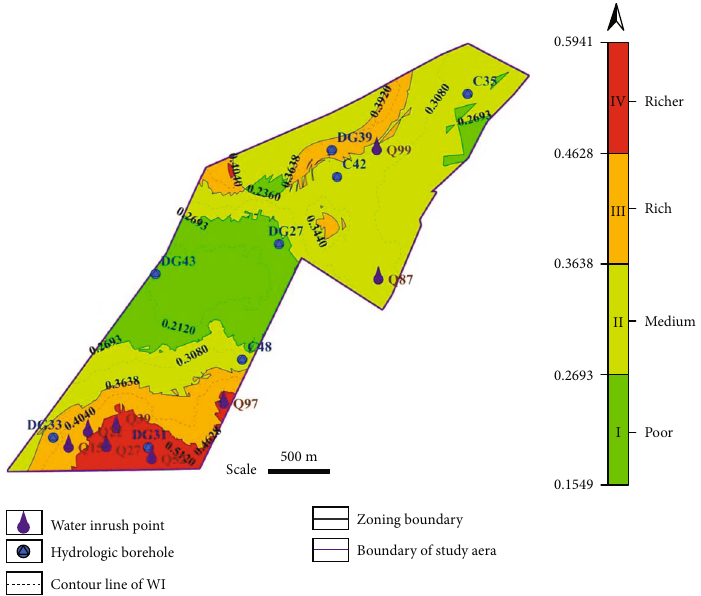
Figure 7: Water yield zoning map based on the WYPI model weighted by the FDAHP.